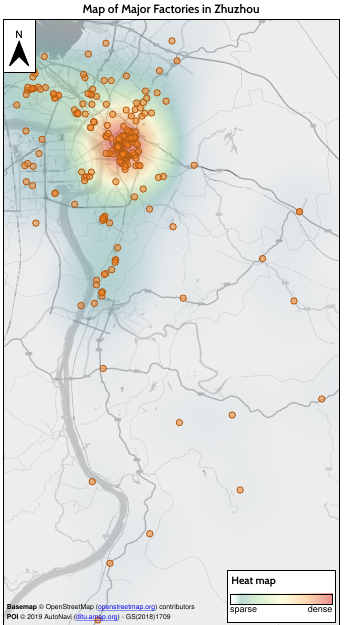
Figure 12. Spatial distribution and heat map of major factories in